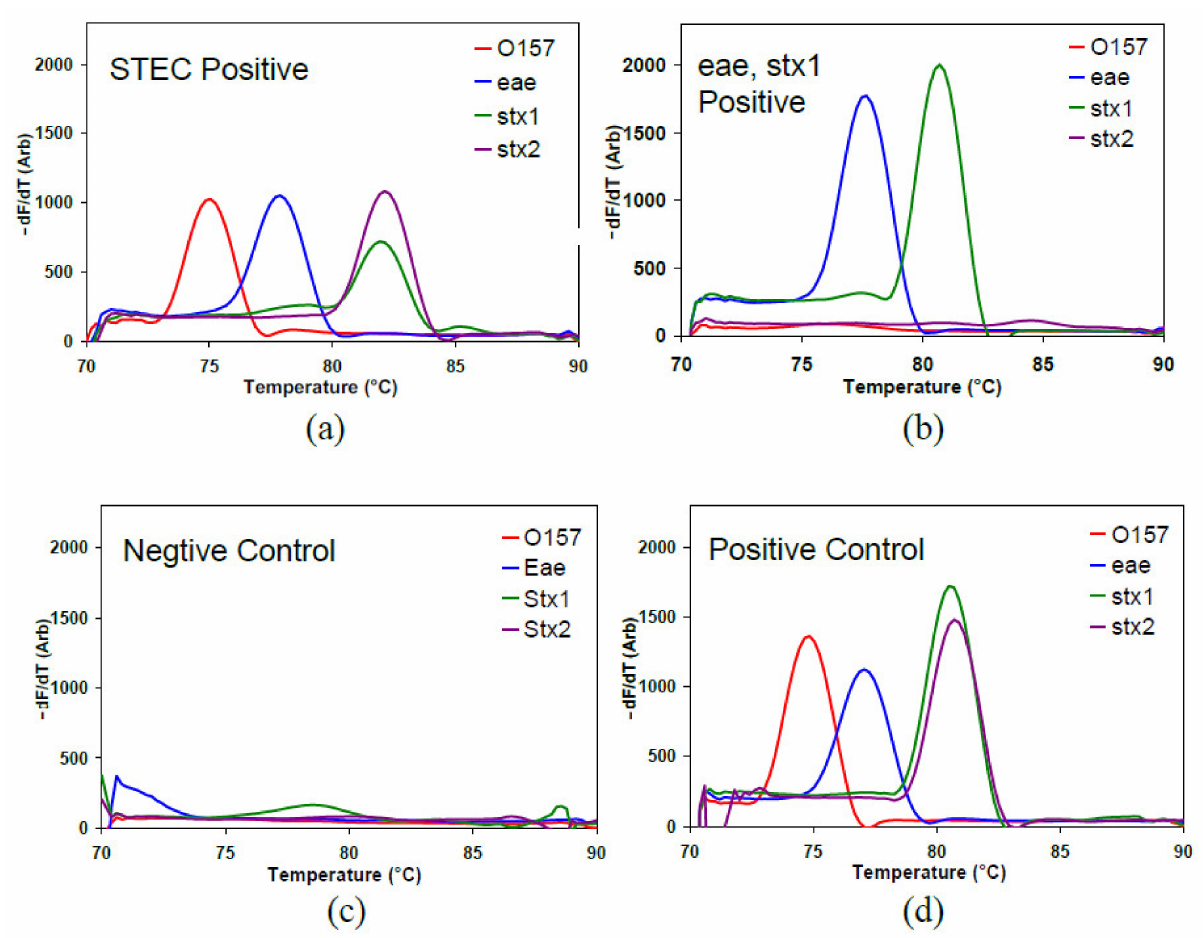
Figure 3. Representation of MCA data of the cassette PCR for two beef carcass swab samples; ( a ) a STEC positive; ( b ) positive for eae and stx1 only; ( c ) the negative control (water); ( d ) the positive control of the cassette. These images were previously published in Manage et al.